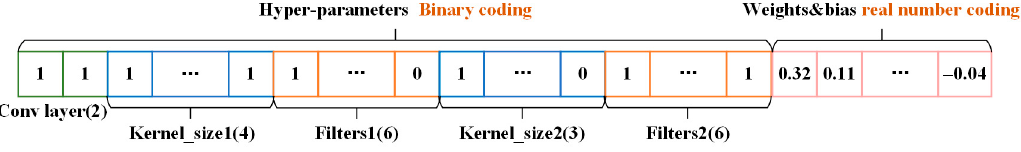
Figure 4. Particle example. Figure 4. Particle